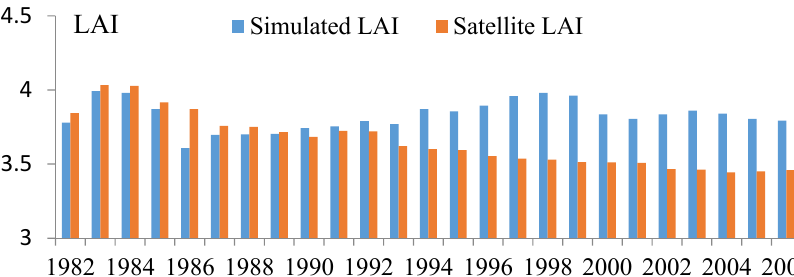
Figure 8. Comparison between simulated and satellite annual maximum LAI.